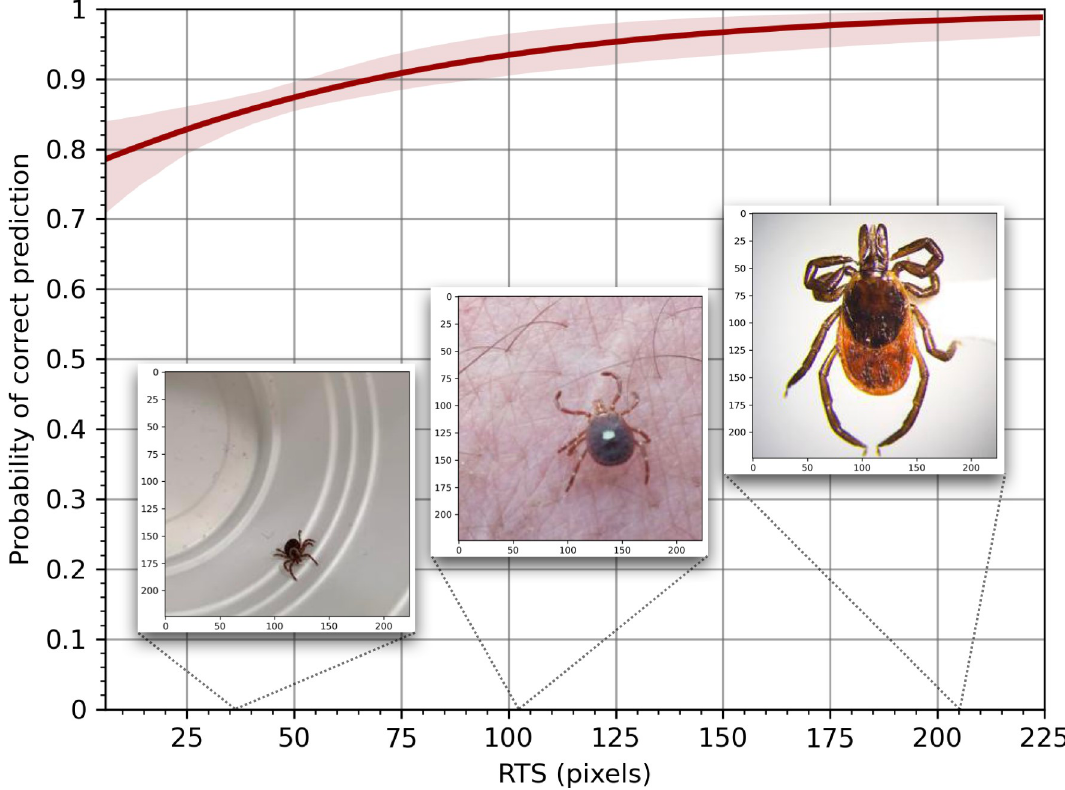
Fig 7. Binary logistic regression of the relationship between a correct prediction and the relative tick size